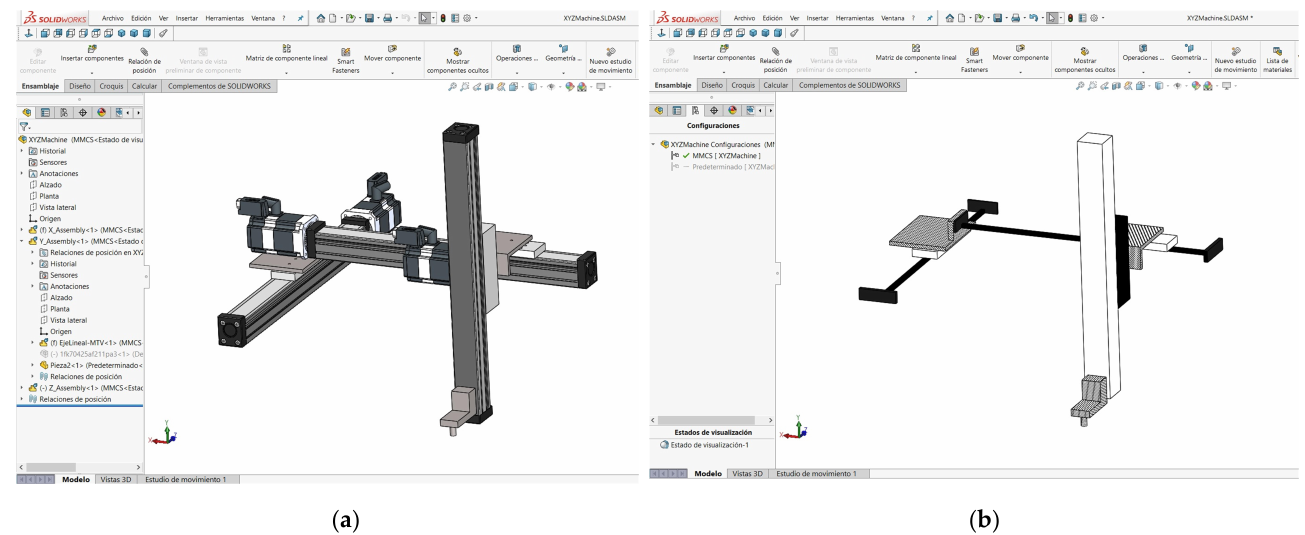
Figure 22. XYZ machine CAD layers. ( a ) 3D CAD layer; ( b ) MMCS CAD layer.